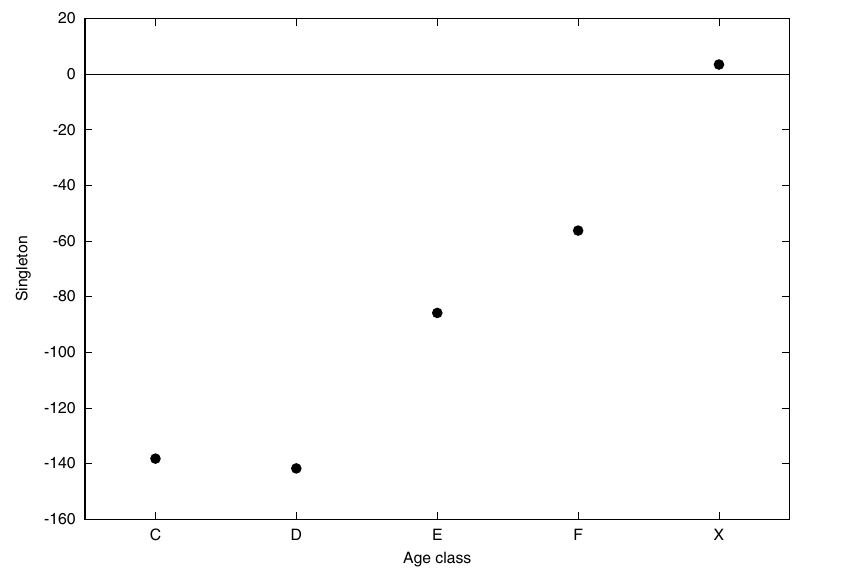
Figure 6. z 0 values (y-axis) of each age class (x-axis) are reported.